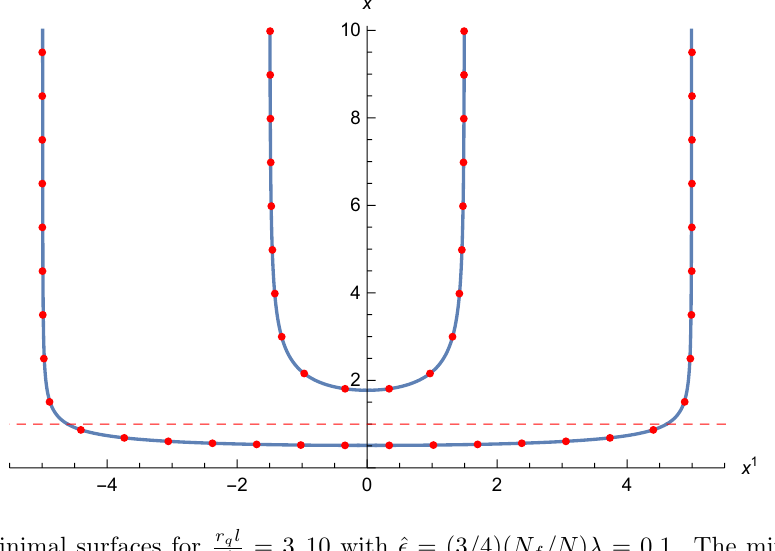
Figure 1 . Minimal surfaces for r q l p = 3 ; 10 with ^ (cid:15) = (3 = 4)( N f =N ) (cid:21) = 0 : 1. The minimal surface (cid:21) for the wider boundary strip penetrates the cavity (location marked by horizontal dashed line).